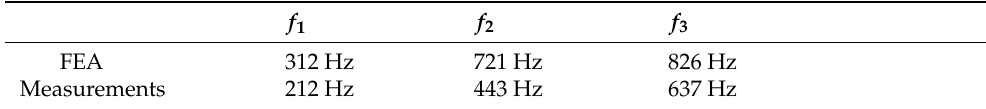
Table 4. Calculated and measured natural frequencies of the balanced manipulator arm for θ 1 = 88.2